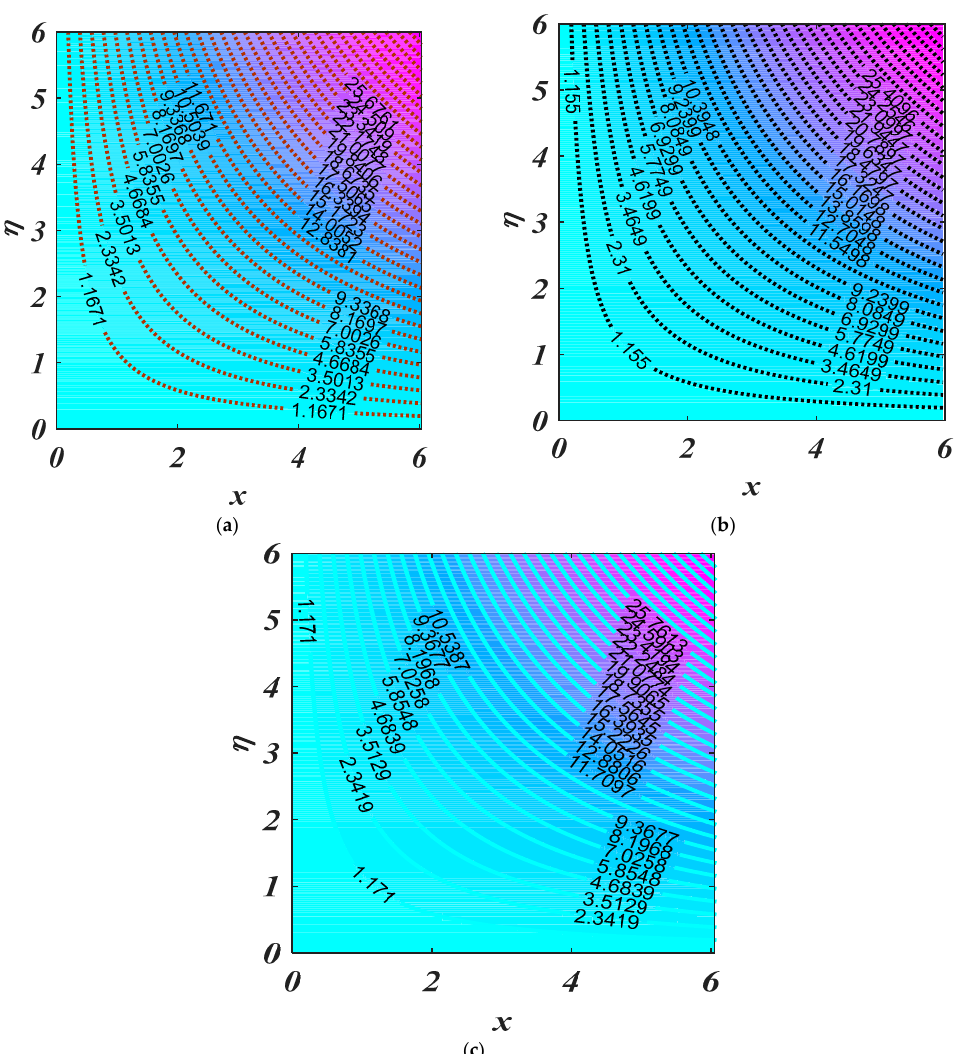
Figure 16. Streamline for ( a ) shrinking Wedge ( − 2.5); ( b ) stretching Wedge (2.5); ( c ) static Wedge (0).